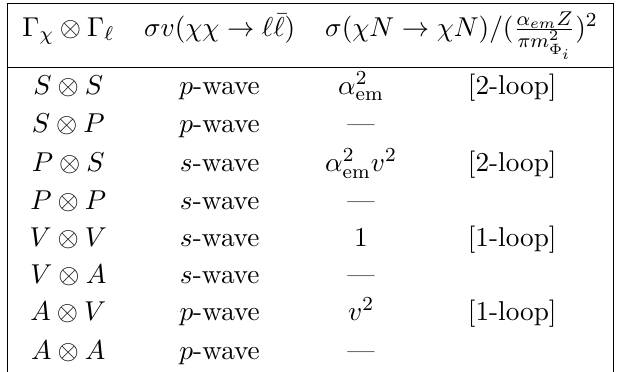
Table 1 . Dominant contribution to LDM annihilation cross section and scattering cross section suppression by small parameters for loop induced DM-nucleon scattering for eight Lorentz struc- tures. Here v is the DM velocity.